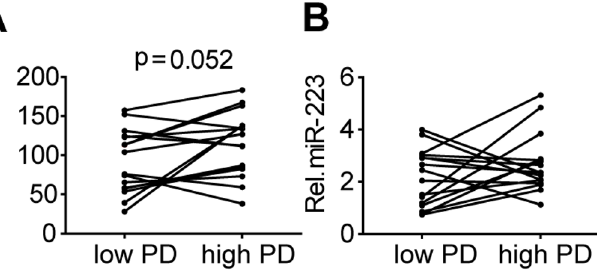
Fig 5. MiR-21 is upregulated with increasing population doublings in T-cell clones. Relative expression of (A) miR-21 and (B) miR-223 in T cell clones harvested at lower and higher number of population doublings (PD). MiRNA expression was normalized to the expression of